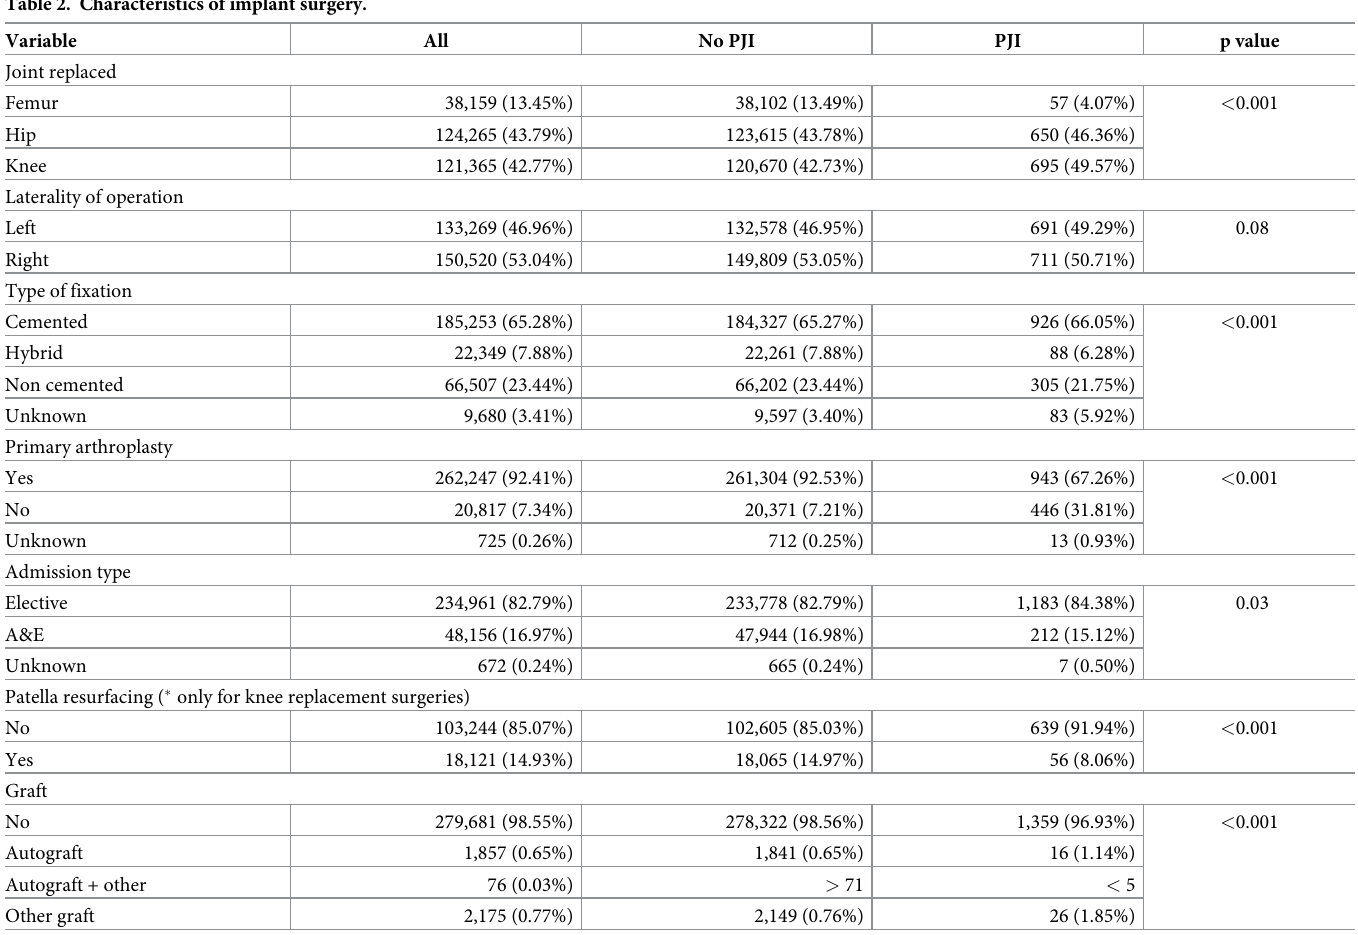
Table 2. Characteristics of implant